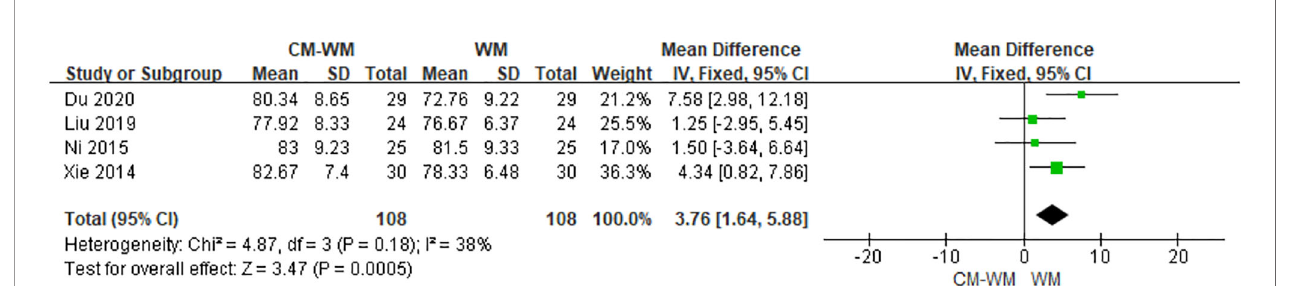
FIGURE 16 | Meta-analyses on KPS.